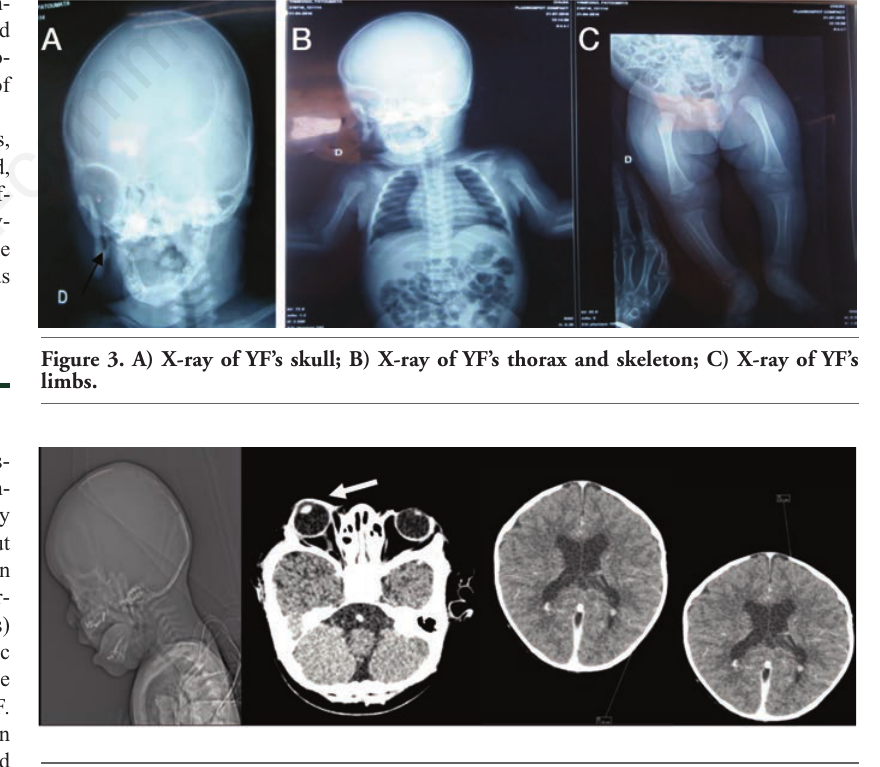
Figure 4. Cerebral CT showing more visible exophthalmia on the right and atresia of the choanal and the absence of parenchymatous